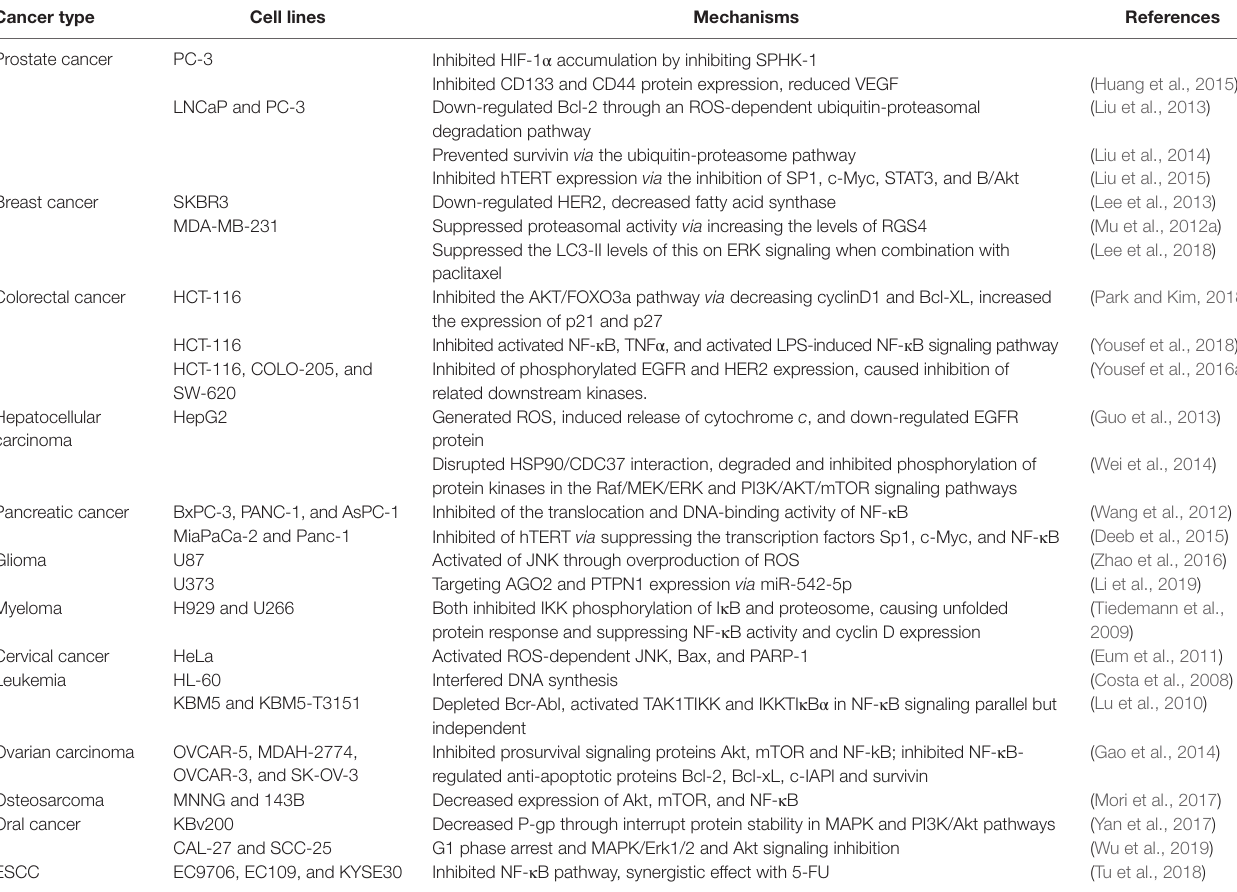
TABLE 3 | Anti-cancer mechanisms of pristimerin in different cell lines.